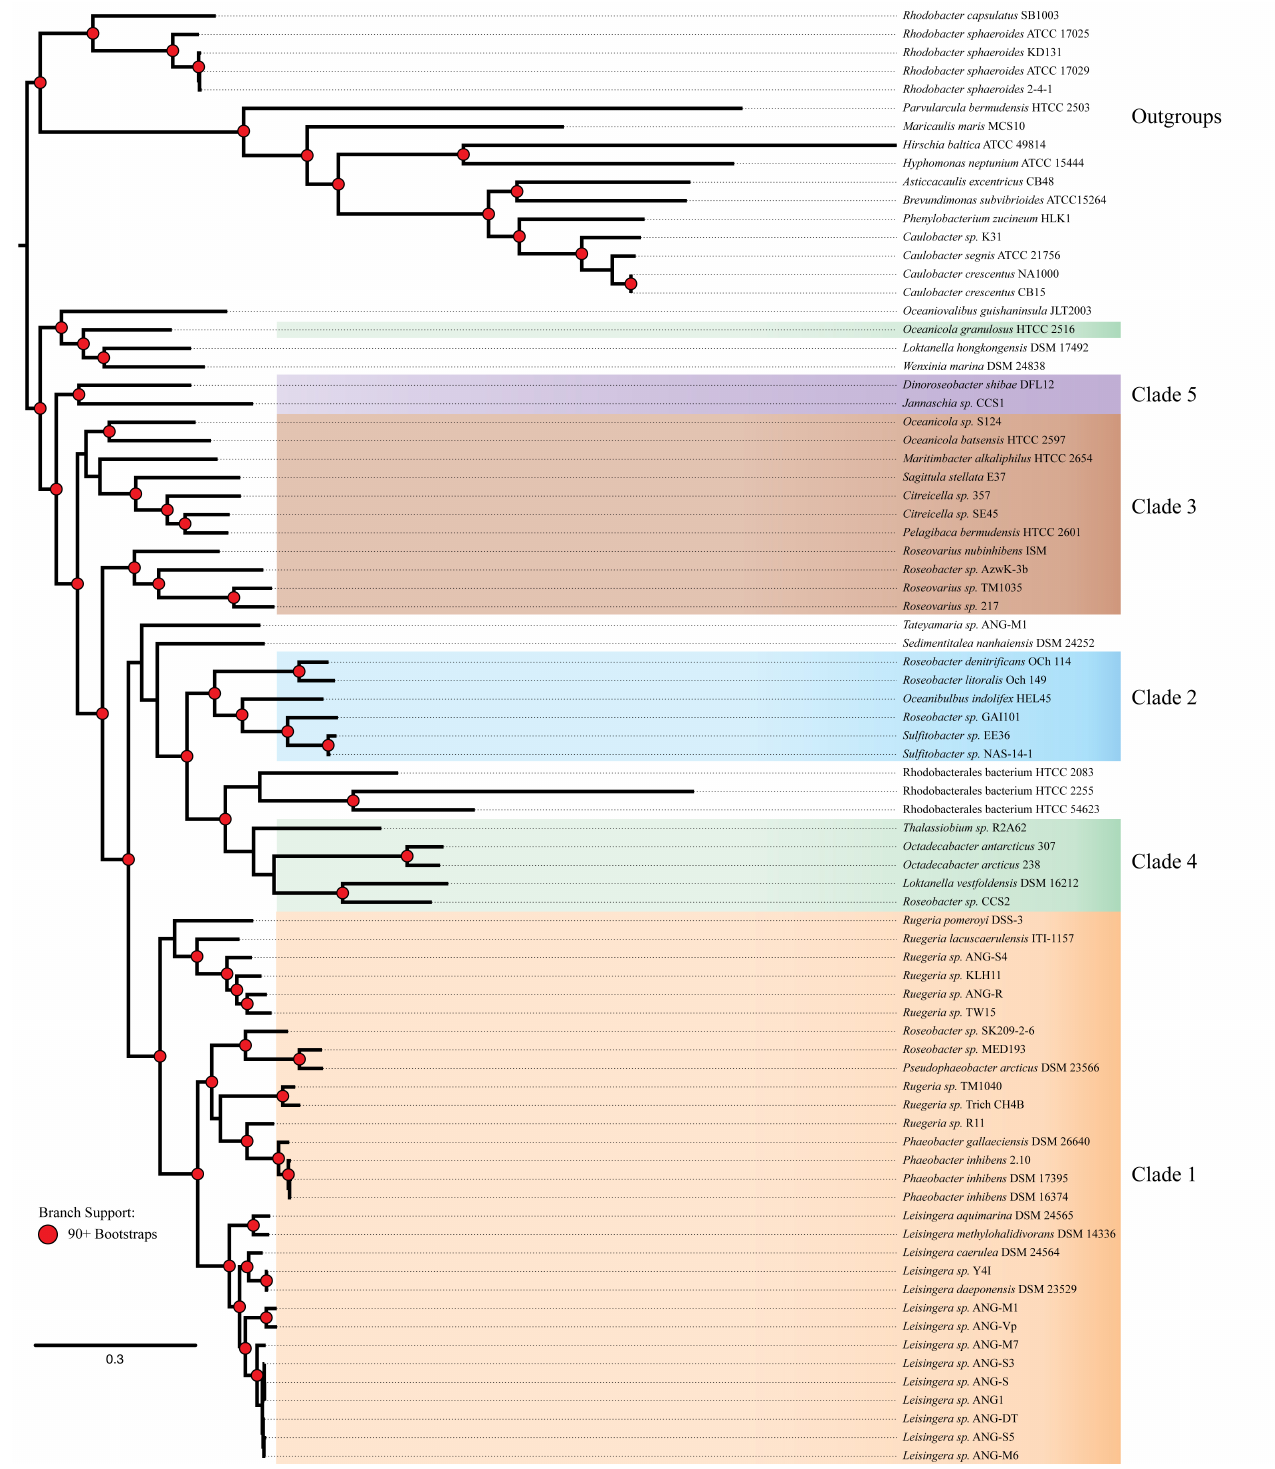
Supplementary Figure 1. Ribosomal protein phylogeny of the Rosebacter clade. Phylogenetic analysis of 51 ribosomal proteins results in a topology with the ANG isolates grouping in two large two sister clades. Organisms are colored by which of the five clades they fell into as reported by Newton et. al (Newton et. al., 2010). The three “Rhodobacterales bacteria” appear to be long-­‐branch artifacts in this phylogeny and when included in the thirty-­‐three gene topology (Figure 2). HTCC 2083 exists on a very long branch with lesser support than many of the other branches in Newton’s phylogeny. Thus, all three were removed from the dataset in further